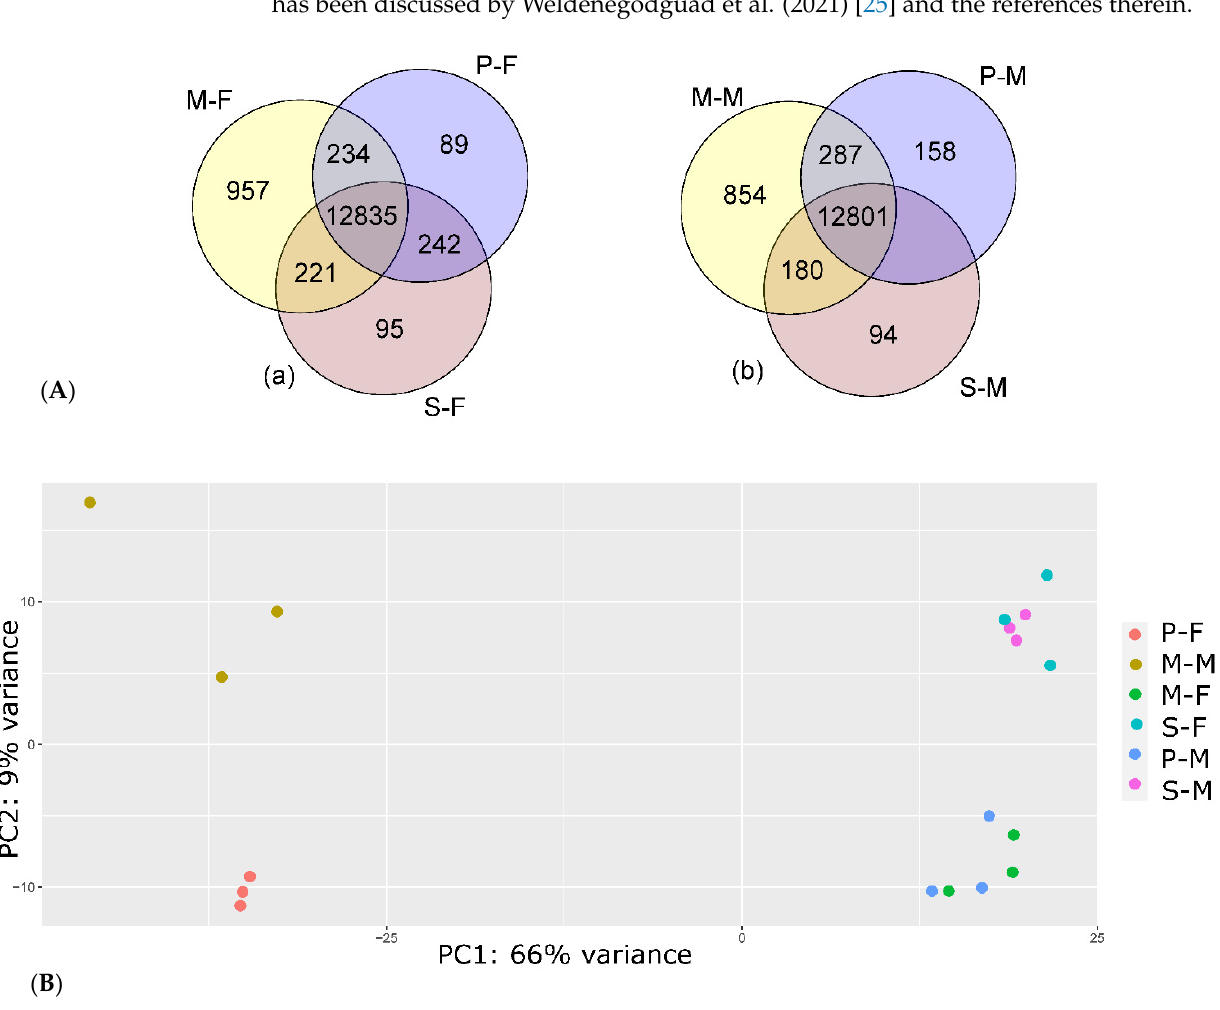
Figure 1. Sample relatedness. ( A ) Venn diagram showing overlap of expressed genes (CPM ≥ 0.5 for at least two samples) among the tissues in male ( a ) and female ( b ) reindeer. ( B ) PCA plots of the analysed samples based on expression